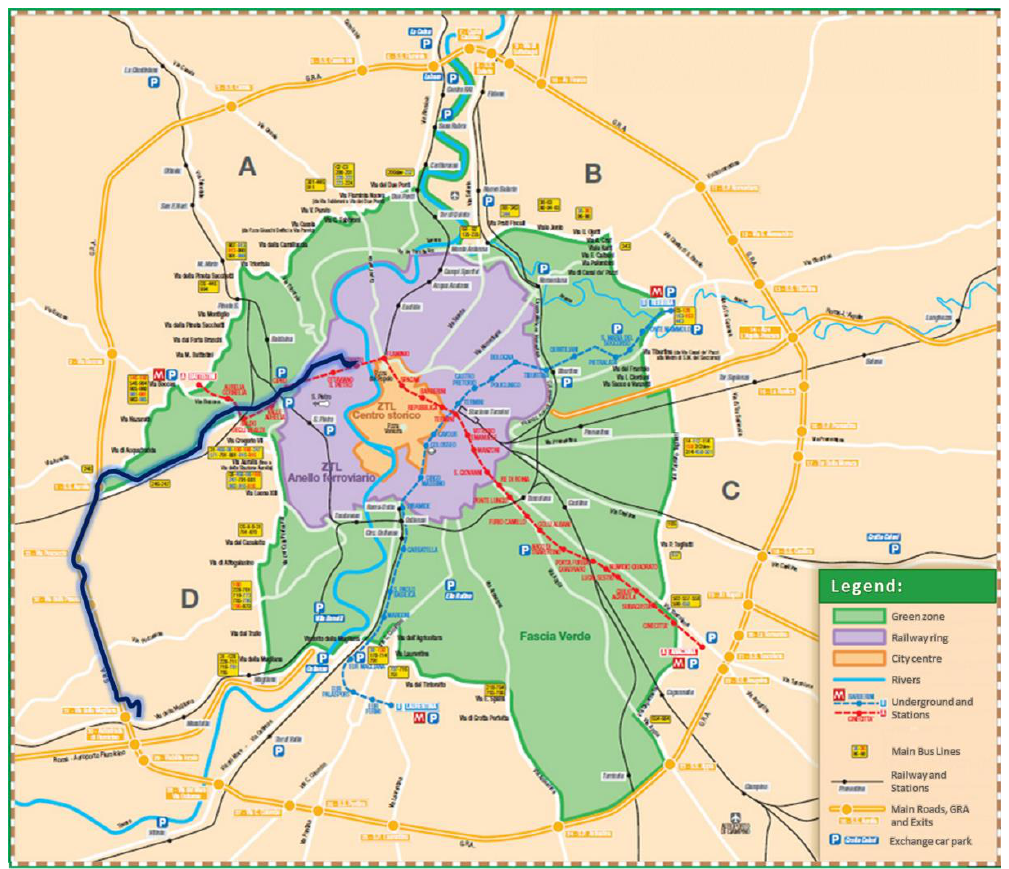
Figure 4. Map of Rome (highlighted in green: LEZ—low emission zone; blue line: Test drive path).